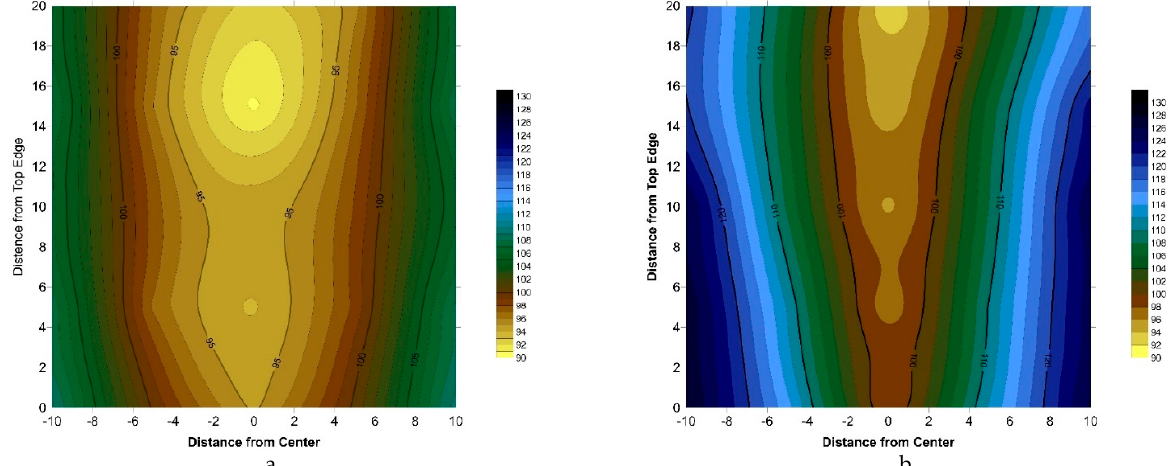
Figure 8. Color-coded contour maps for the Hv values recorded on the top LS of the ECAP processed rods through ( a ) 1-P and ( b ) 2-Bc.